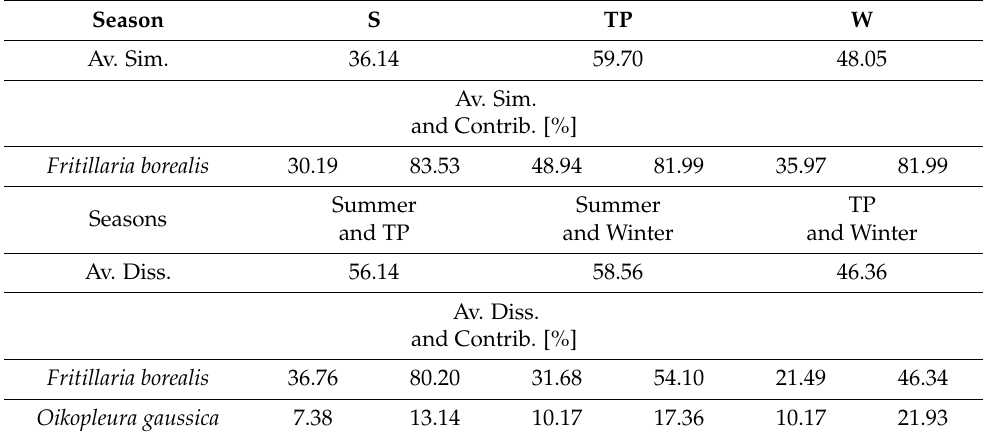
Table 2. Values of SIMPER analysis of appendicularian taxa accumulating 90% similarity for abun- dance, in Admiralty Bay; S—summer, TP—transition period, and W—winter.